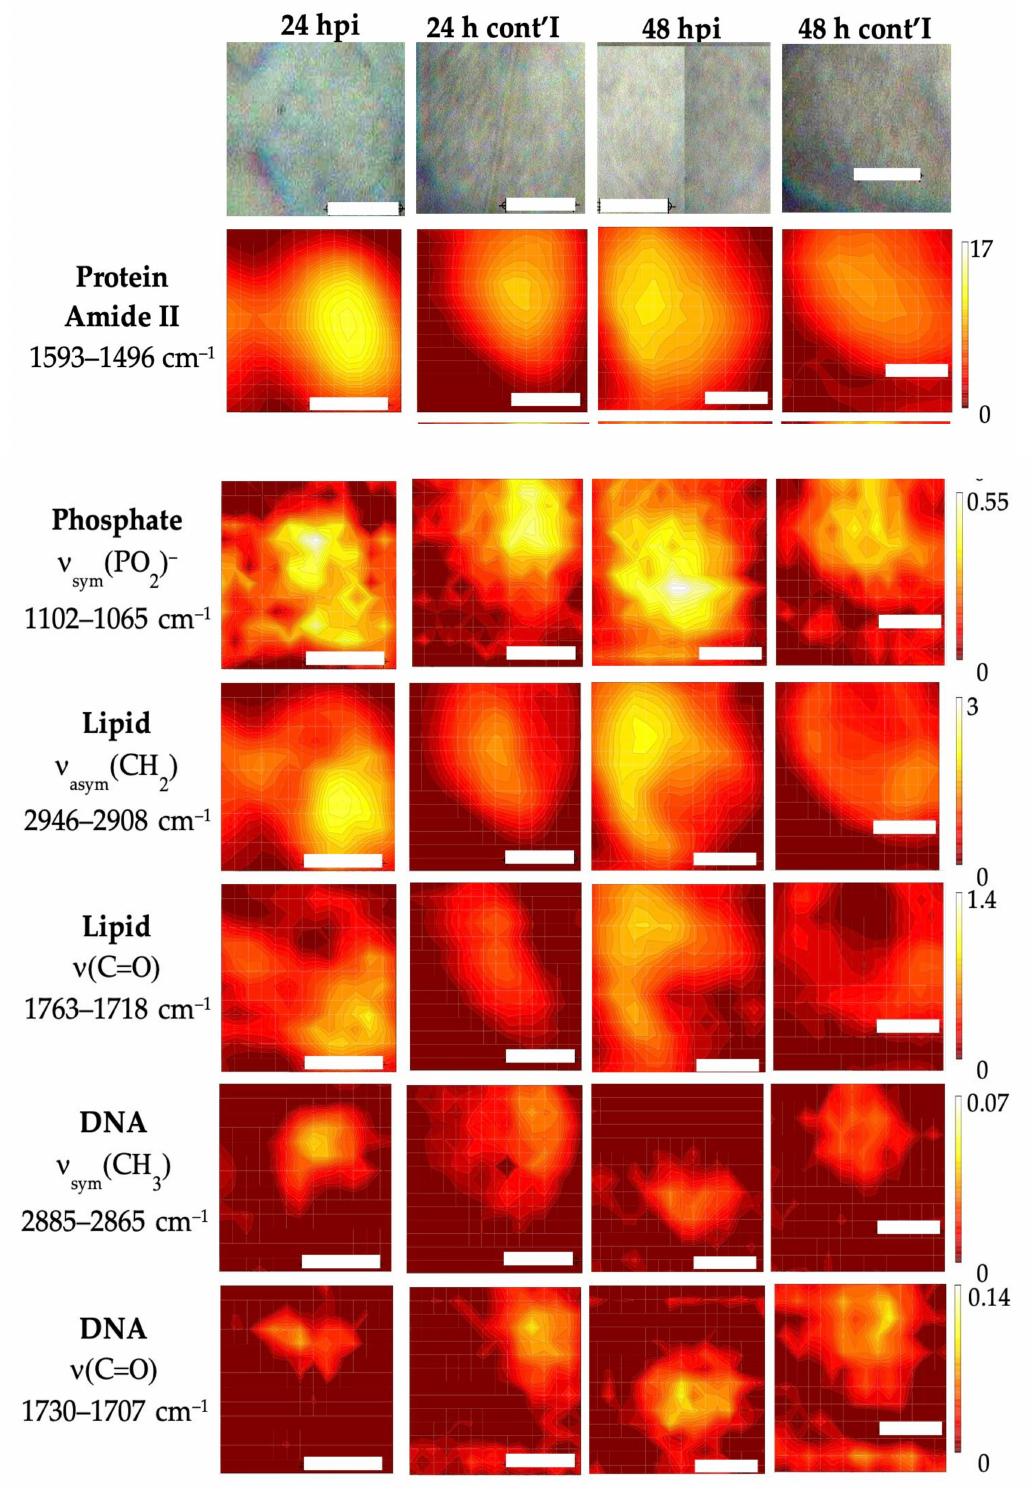
Figure 3. A representative set of visible images (top row) and FTIR images (integration range shown on the left column) of infected and control cells at 24 and 48 hpi. Scale bars = 10 µ